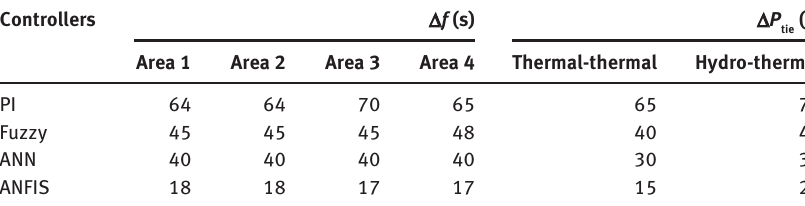
Table 2. Comparative Study of Settling Time.